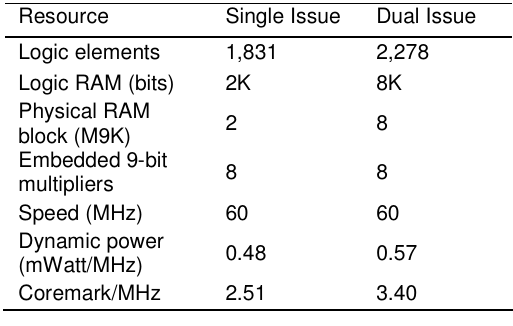
Table 5. Summary of FPGA resource utilization for the dual issue processor with a single ALU.